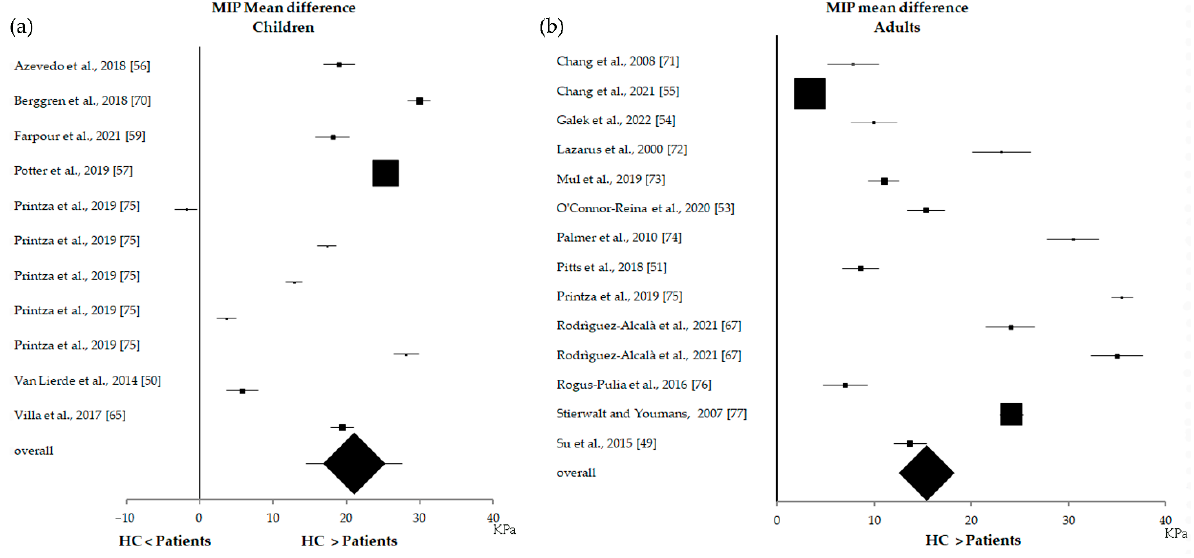
Figure 6. Forest plot of the MIP results from children ( a ) and adults ( b ).